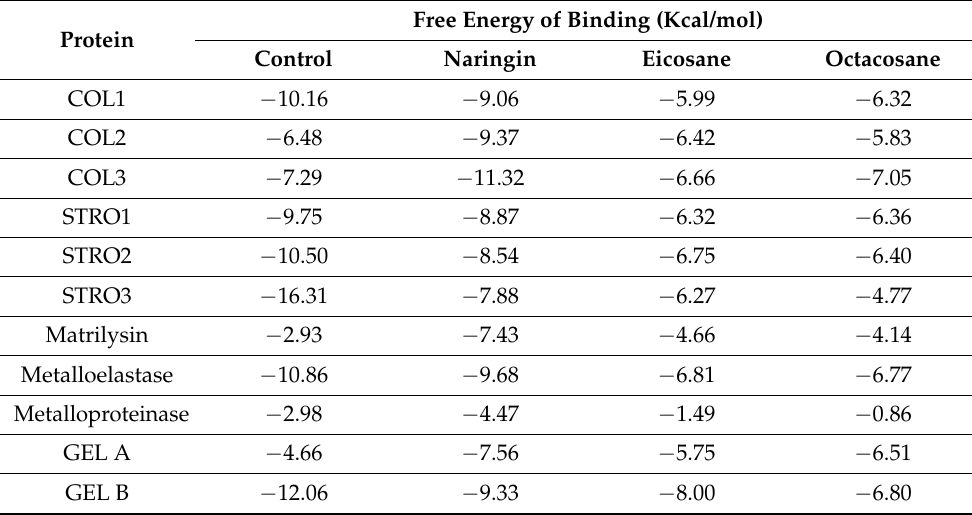
Table 5. Dissociation constant (kD) of studied compounds against the proteins.